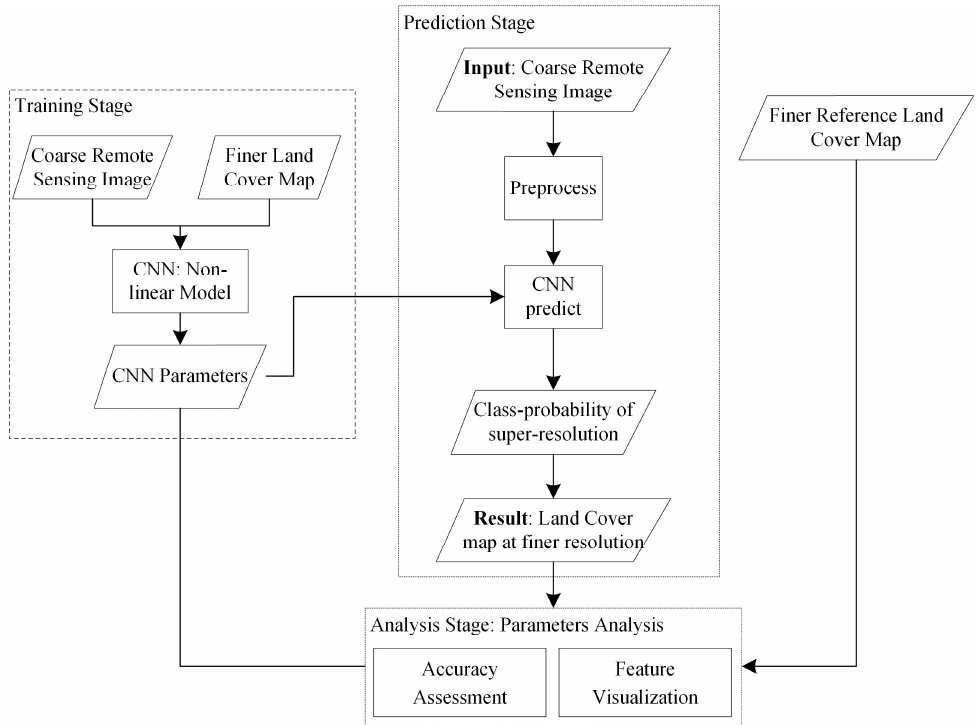
Figure 1. Three stages of flowchart.